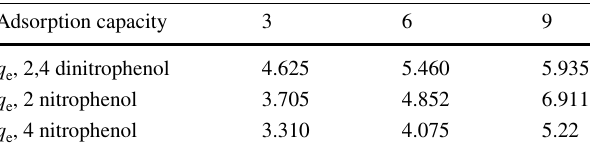
Table 7 Effect of pH on the adsorption capacity of phenolic com- pounds Adsorption